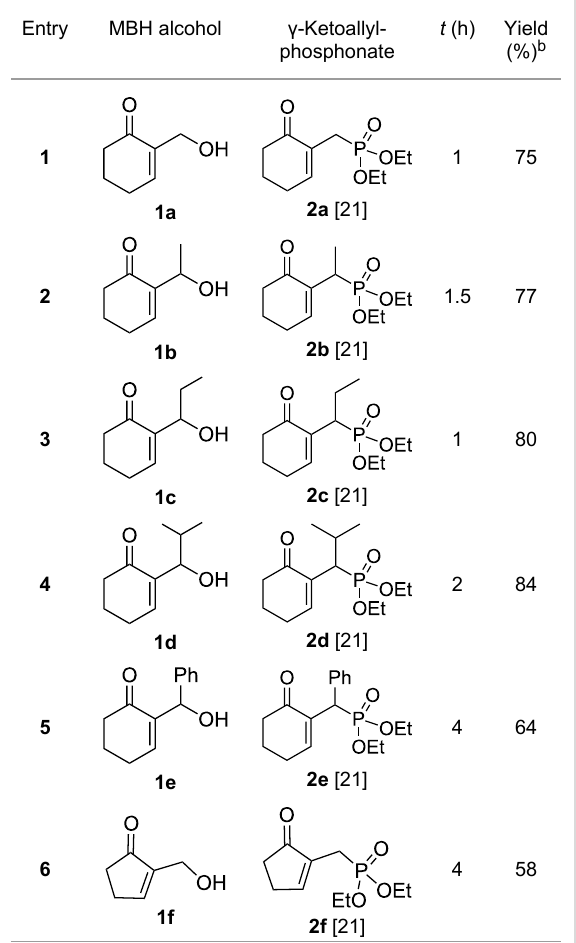
Table 2: Direct conversion of cyclic MBH alcohols 1a–f into γ -ketoallyl- phosphonates 2a–f a